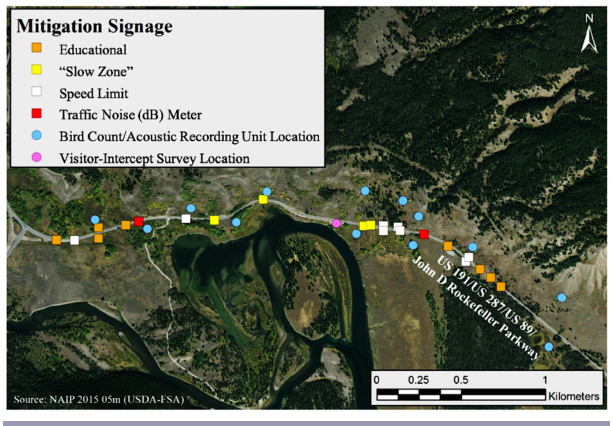
Fig. 1 . Survey locations and site layout along experimental road